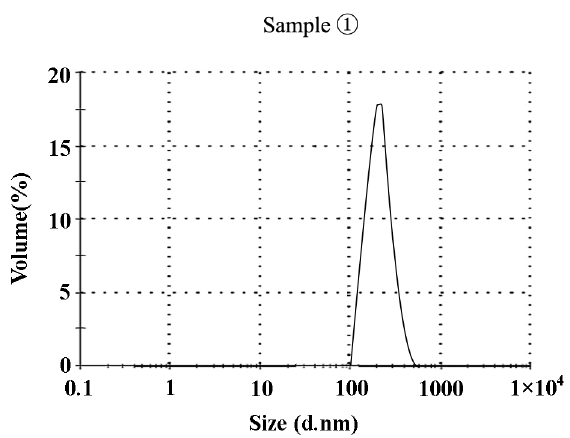
Figure 3. The particle size distribution of the system when the molar ratio of epoxy groups is E51:ED = 3:1.